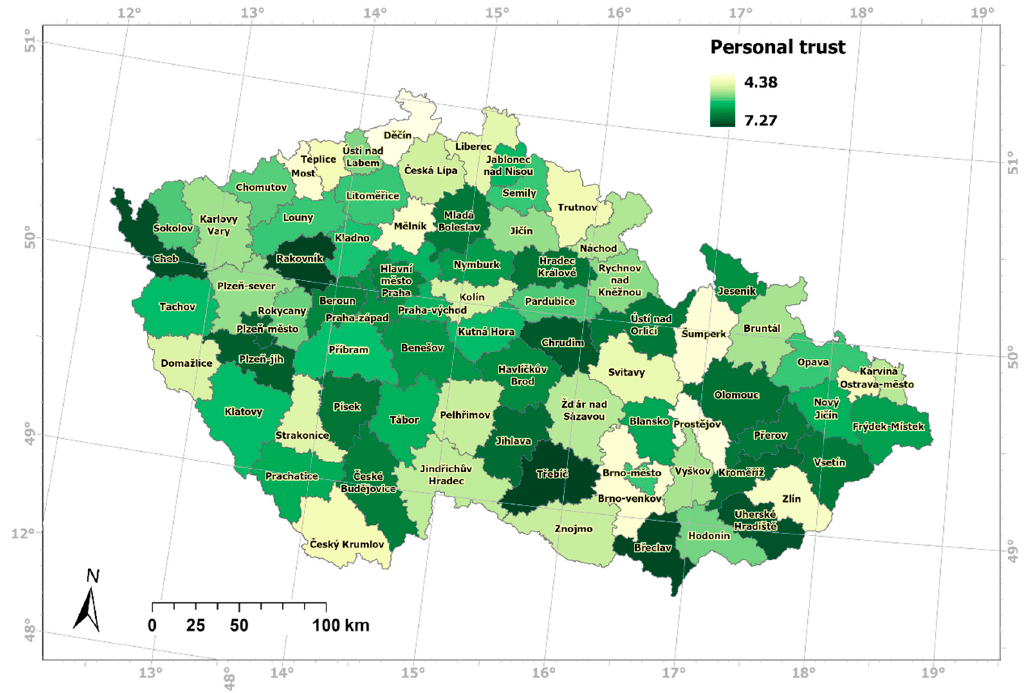
Figure 4. Spatial differentiation of trust in districts of Czechia.